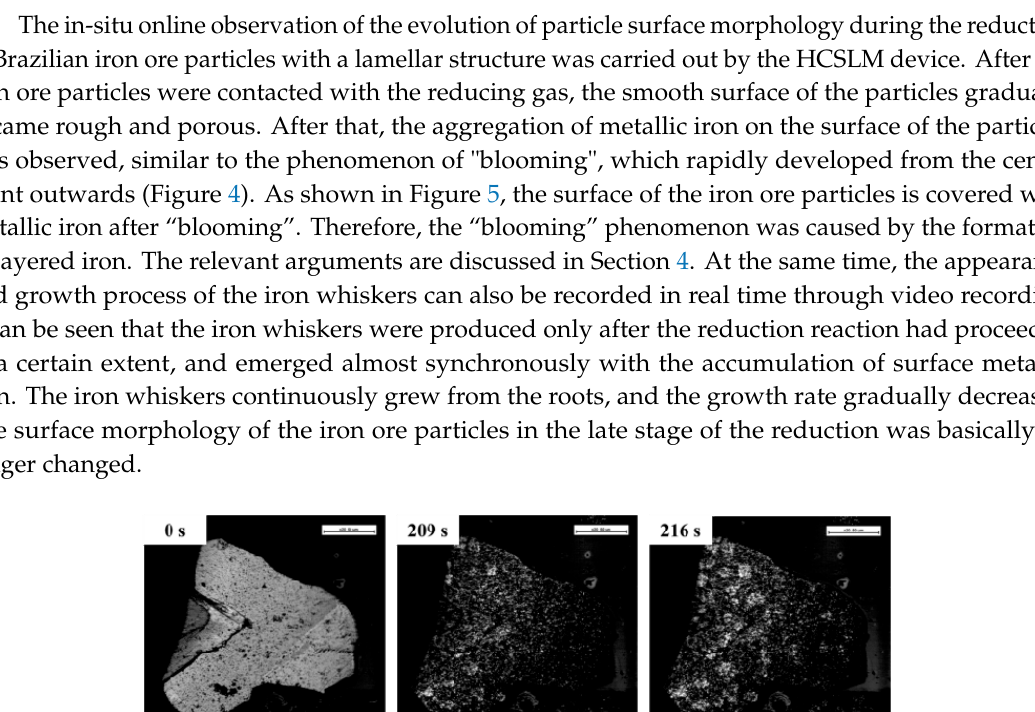
Figure 5. The EDS result of the particle surface after “blooming” happened.